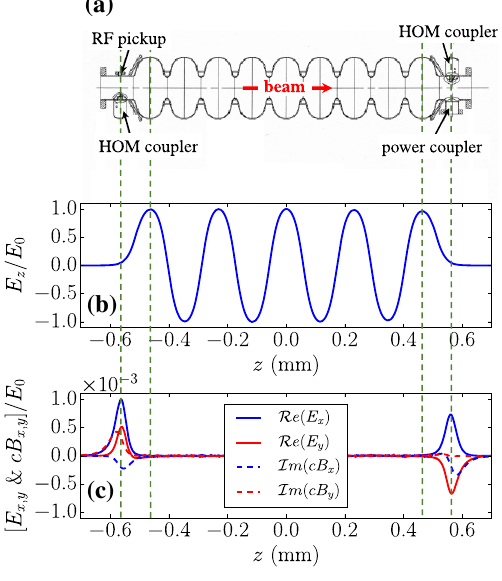
FIG. 1. Schematics of the TESLA-type cavity considered in the present study (a) along with the axial E z ≡ E z ð r ¼ 0 ; z Þ (b) and transverse (c) electromagnetic fields simulated on the cavity geometric axis r ¼ 0 . In (b) and (c) the field are dumped at a time where the electric E x , E y , and E z are real while the magnetic cB x and cB y fields are imaginary. All the fields are normalized to the maximum axial electric field E 0